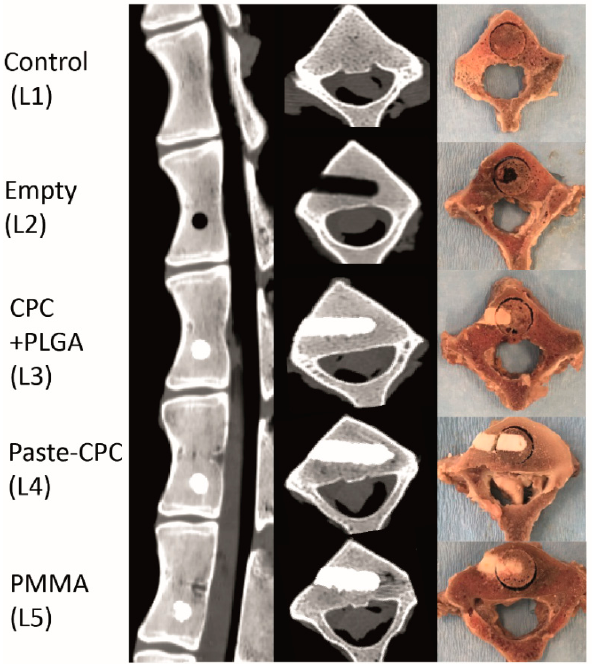
Figure 1. Depiction of cement localization by computed tomography (left—sagittal; middle—transversal) or gross morphology (right); L1 = untouched control; L2 = empty defect; L3 = CPC + PLGA; L4 = Paste-CPC; L5 = PMMA (Kyphon HV-R). CPC, calcium phosphate cement; PMMA, polymethylmethacrylate; PLGA, poly(L-lactide-co-glycolide). For scalebars please refer to Figure 2.